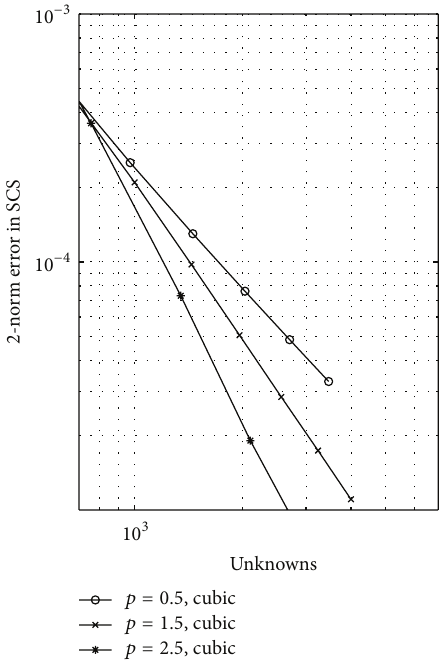
Figure 3: Error in the SCS versus the average edge lengths in the models, for a sphere with 𝑘𝑎 = 2𝜋 . MFIE results from Figure 2 are compared to ideal asymptotic rates of 𝑂(ℎ 2 ) , 𝑂(ℎ 4 ) , and 𝑂(ℎ 6 ) . Also shown is the error obtained with 𝑝 = 2.0 basis functions when used with quadratic-curved models.